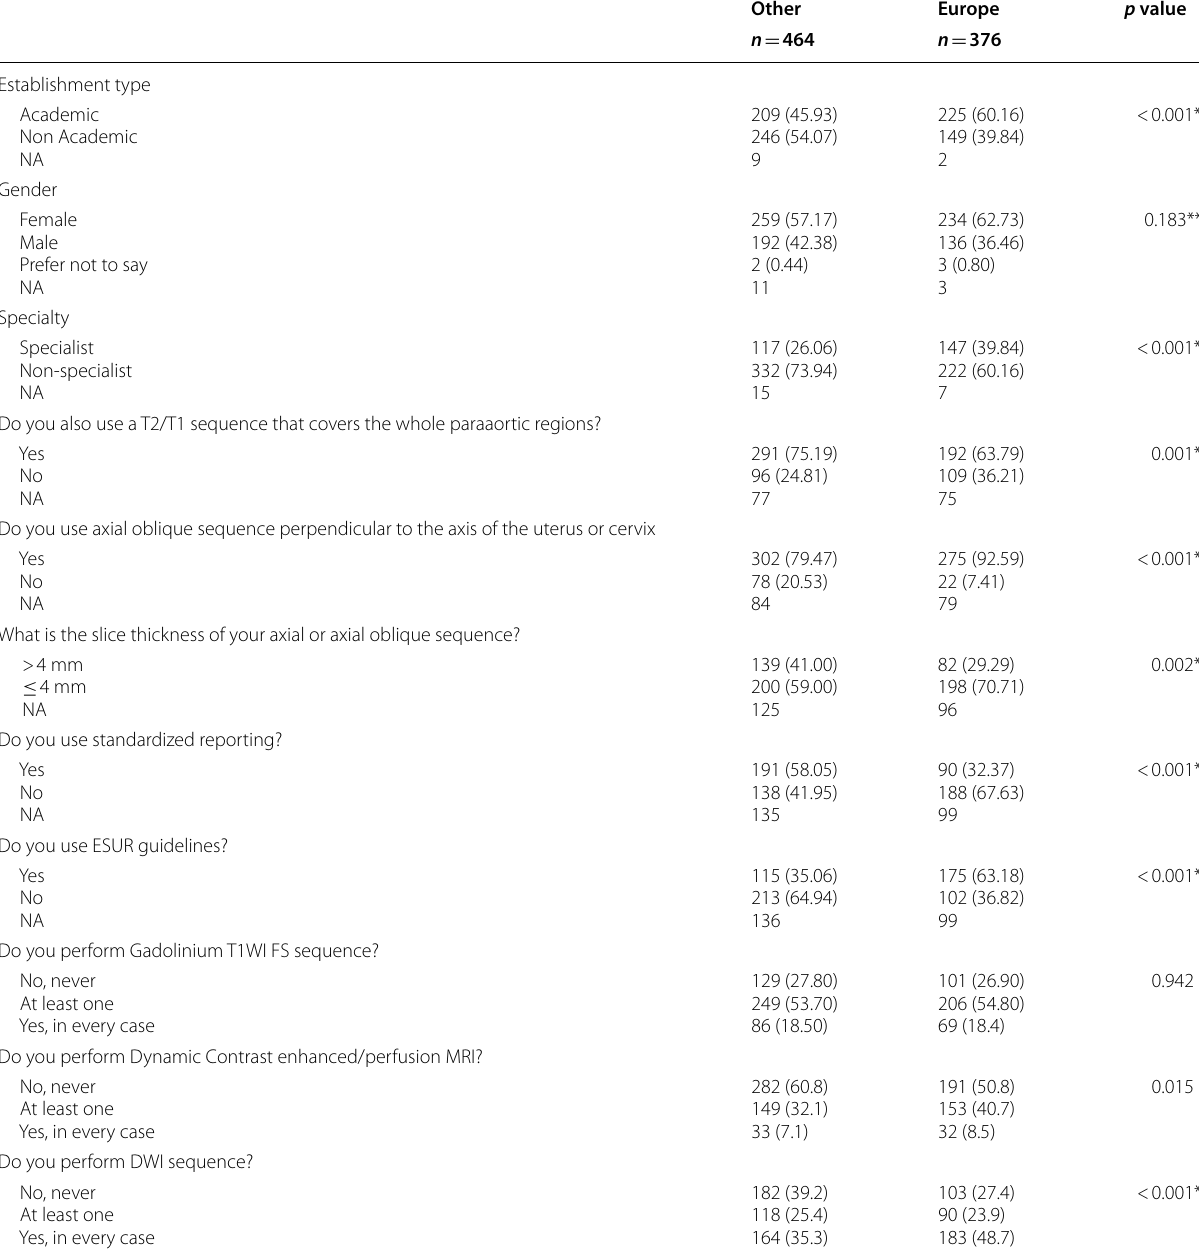
Table 4 Subgroup analysis regarding